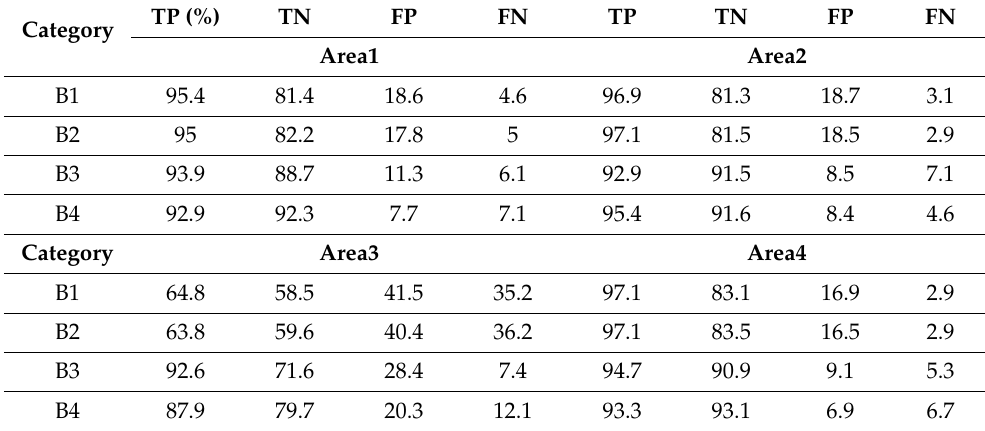
Table 11. The associated performance measurements True Positive (TP), True Negative (TN), False Positive (FP), and False Negative (FN) associated with the highest accuracies achieved using selected features in B category for all four AOIs as listed in Table